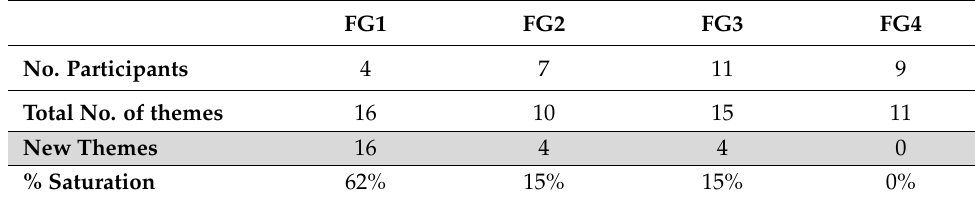
Table 6. Number (No.) of themes emerging from the sample groups of